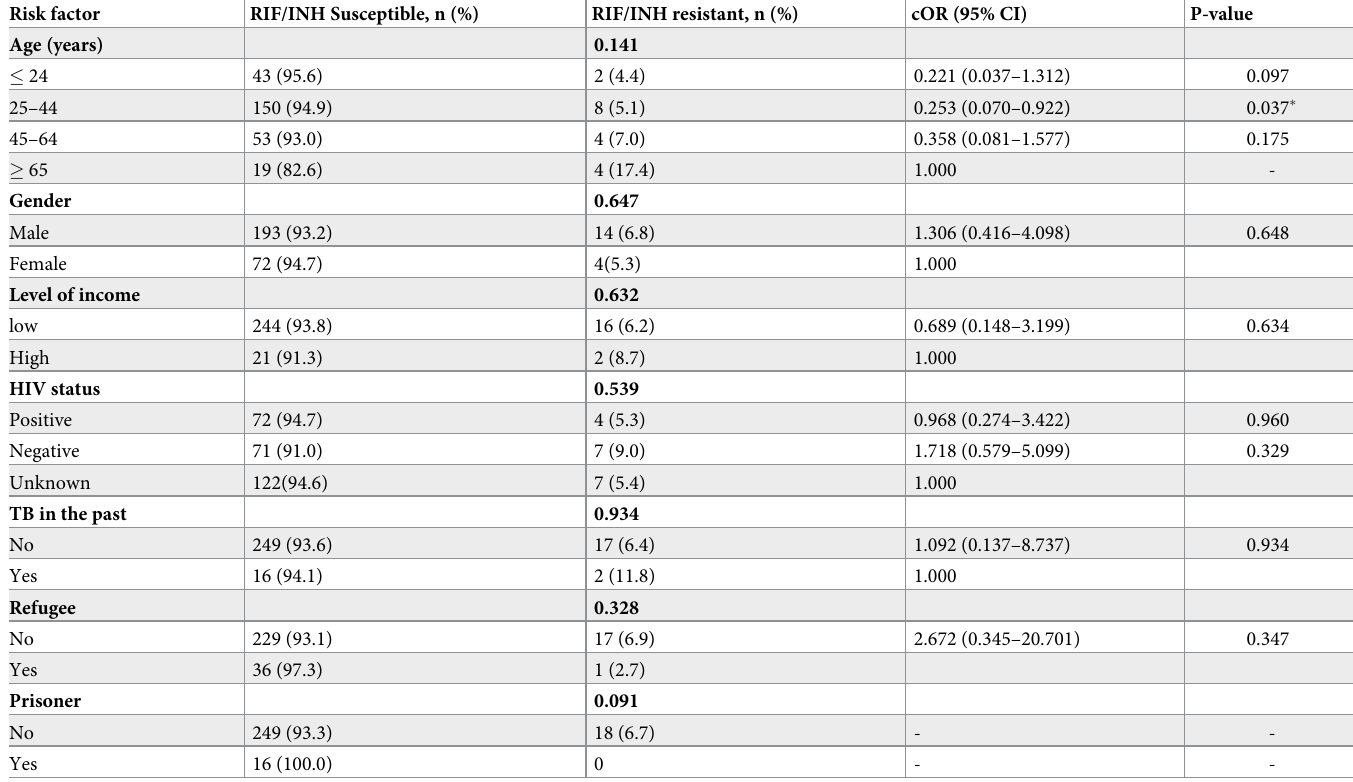
Table 3. Bivariate analysis of factors associated with multidrug resistance among PTB patients in southwestern Uganda.